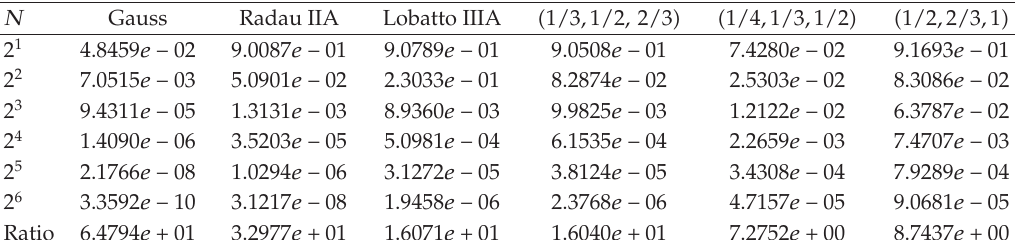
Table 4: The absolute values of absolute errors of u h for example (cid:2) 7.2 (cid:3) with m (cid:4)